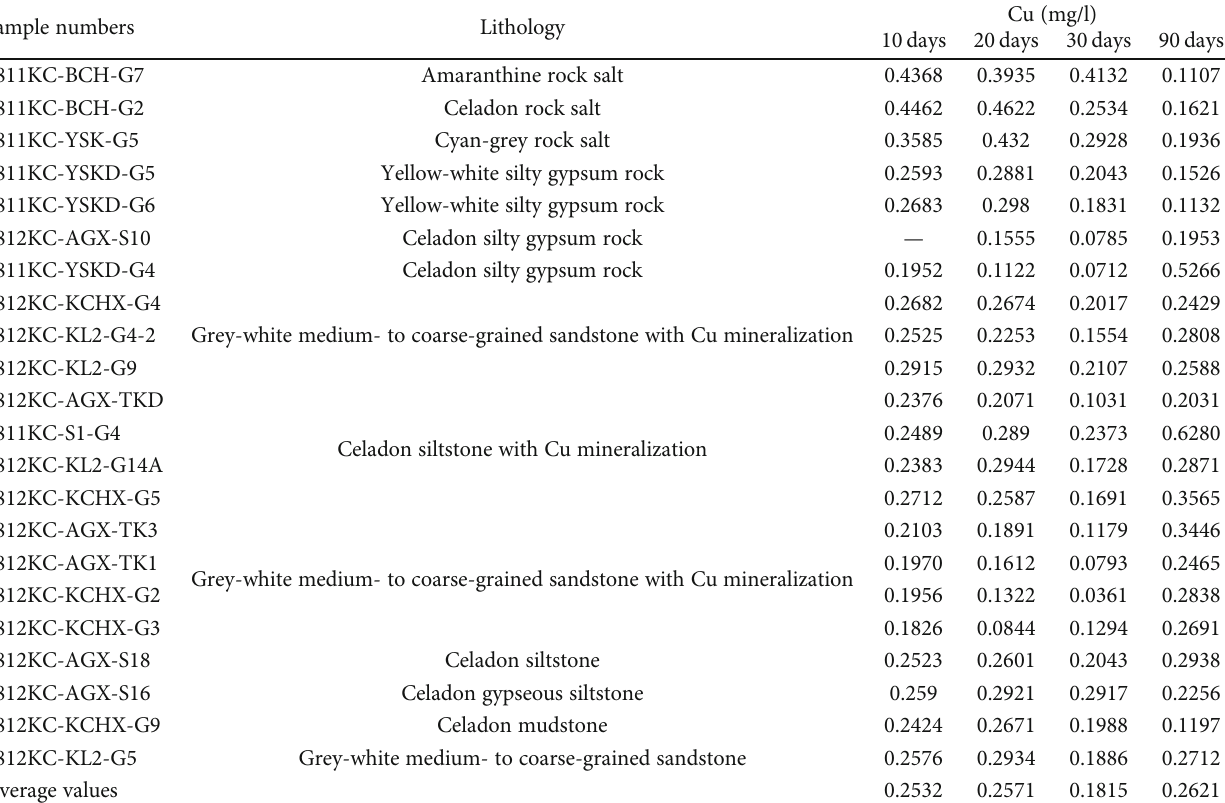
Table 6: Concentration of Cu ion in the saline from di ff erent rocks leached and